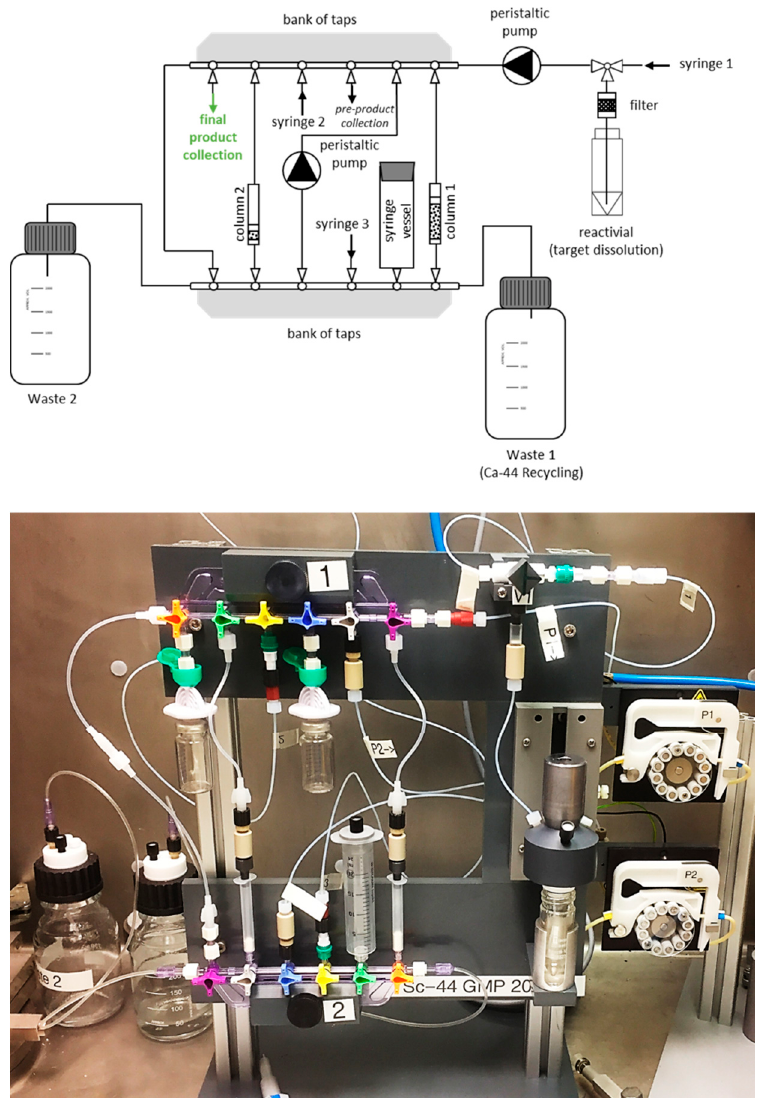
Figure 6. Schematic representation of the 44 Sc chemical separation system (above), with the actual system — using disposable medical grade components — shown below. S1, S2, S3 in the scheme indicate the outside syringe lines (containing Bbraun non-return valves) to introduce the solutions used to perform the separation.